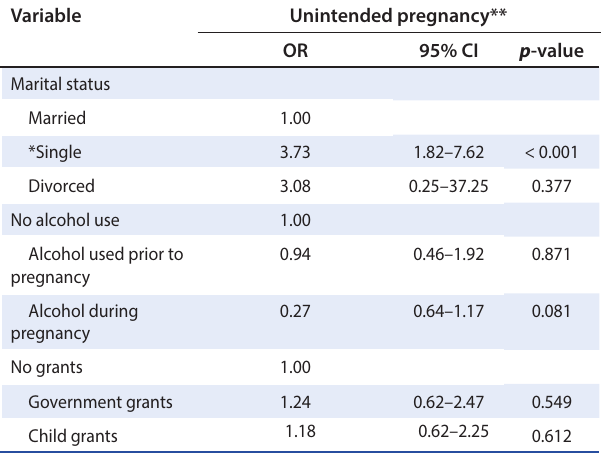
Table 2: Demographic, psychosocial and pregnancy-related variables relative to intended and unintended pregnancy ( n = 328) Variables*